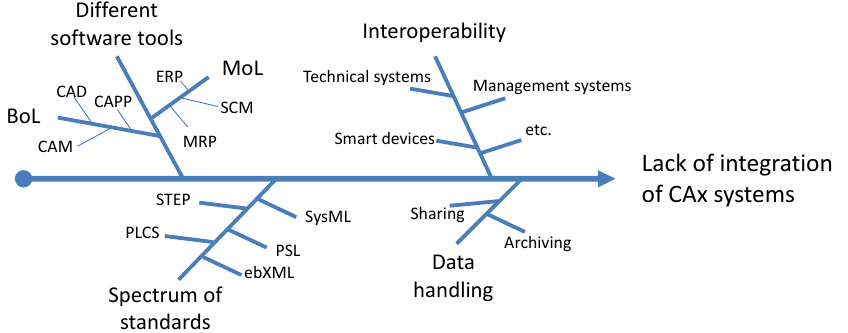
Figure 2. Challenges prohibiting the complete integration of Computer-Aided Technologies (CAx) systems.